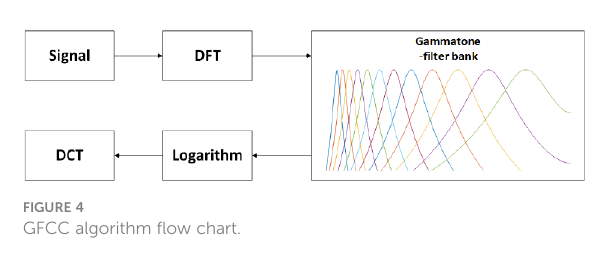
FIGURE 4 GFCC algorithm fl ow